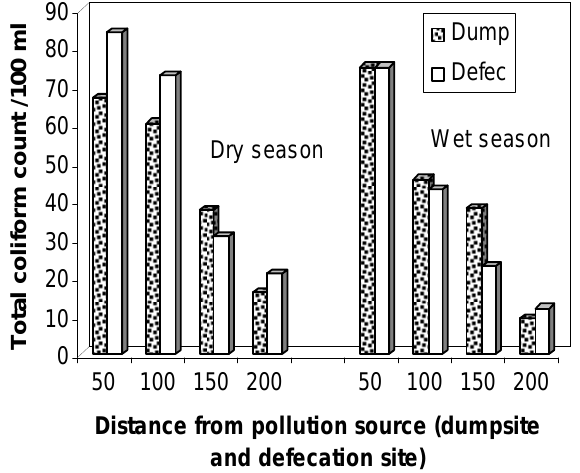
Figure 1 : Decreasing total coliform count (CFU/100 ml) with increasing distance from pollution sources.